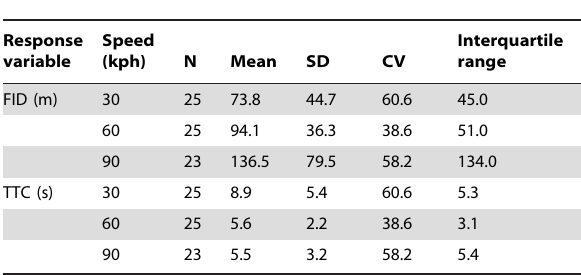
Table 2. Flight-initiation distance (FID) and time-to-collision (TTC) for groups of free-ranging turkey vultures exposed to the approach of a Ford F250 pickup truck from a standard 1.13-km distance at 30, 60, and 90